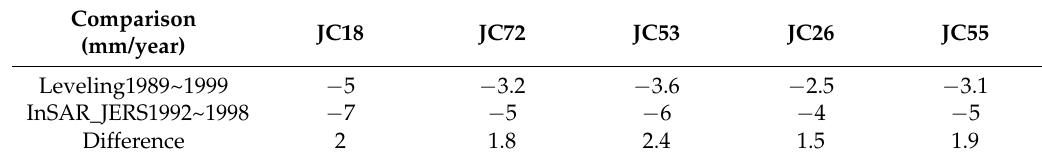
Table 2. Comparison between Interferometric Synthetic Aperture Radar (InSAR) and leveling